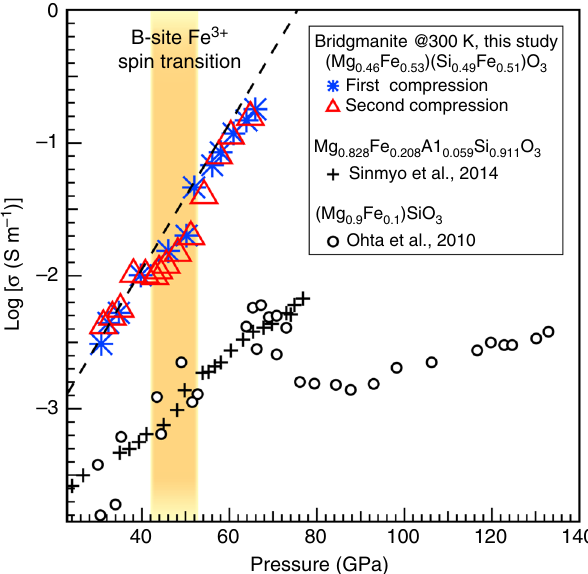
Fig. 5 The electrical conductivity of three bridgmanite compositions across the spin transition at high pressures and 300 K. The red open triangles and blue asterisks are for (Mg 0.46 Fe 3 + 0.53 )(Si 0.49 Fe 3 + 0.51 )O 3 Bdg along two successive compression paths by using the same DAC. The uncertainty is smaller than the symbol size. The yellow region marks the pressure range (43 – 53 GPa) of the spin transition in the B-site Fe 3 + , in this study constrained by complementary XRD and XES measurements. The dashed line is a linear fi t to the electrical conductivity data up to 40 GPa, which predicts slightly higher conductivity than measured data above 54